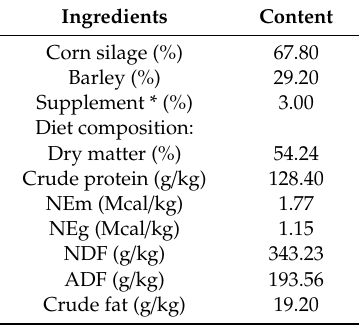
Table 2. Ingredients and chemical composition of feed (as